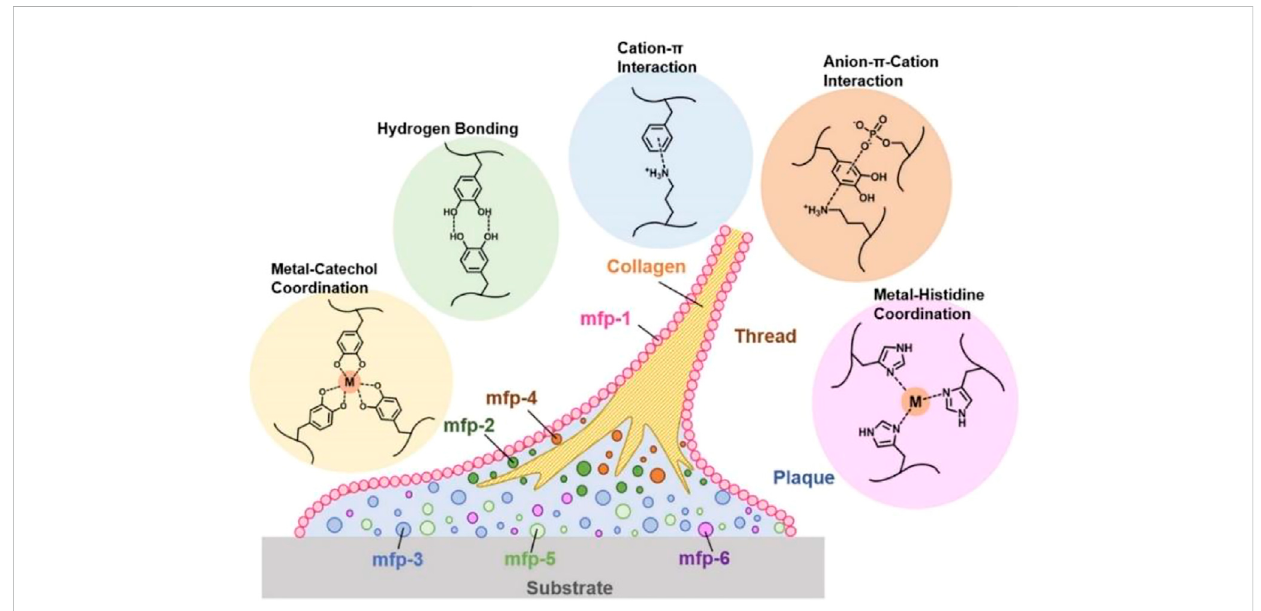
FIGURE 1 Phenolic residues of major mussel foot proteins (mfps) and typical, reversible mussel-inspired interactions (Chen and Zeng,